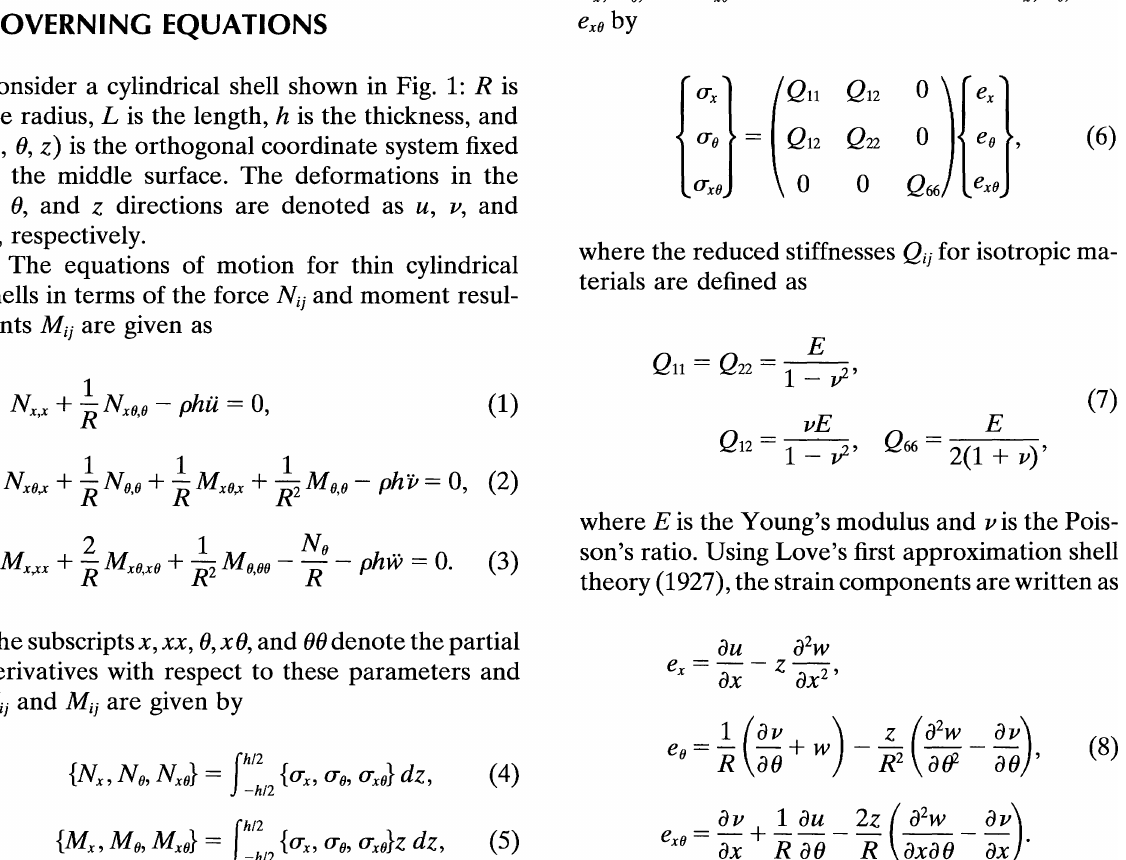
FIGURE 1 Geometry of a cylindrical